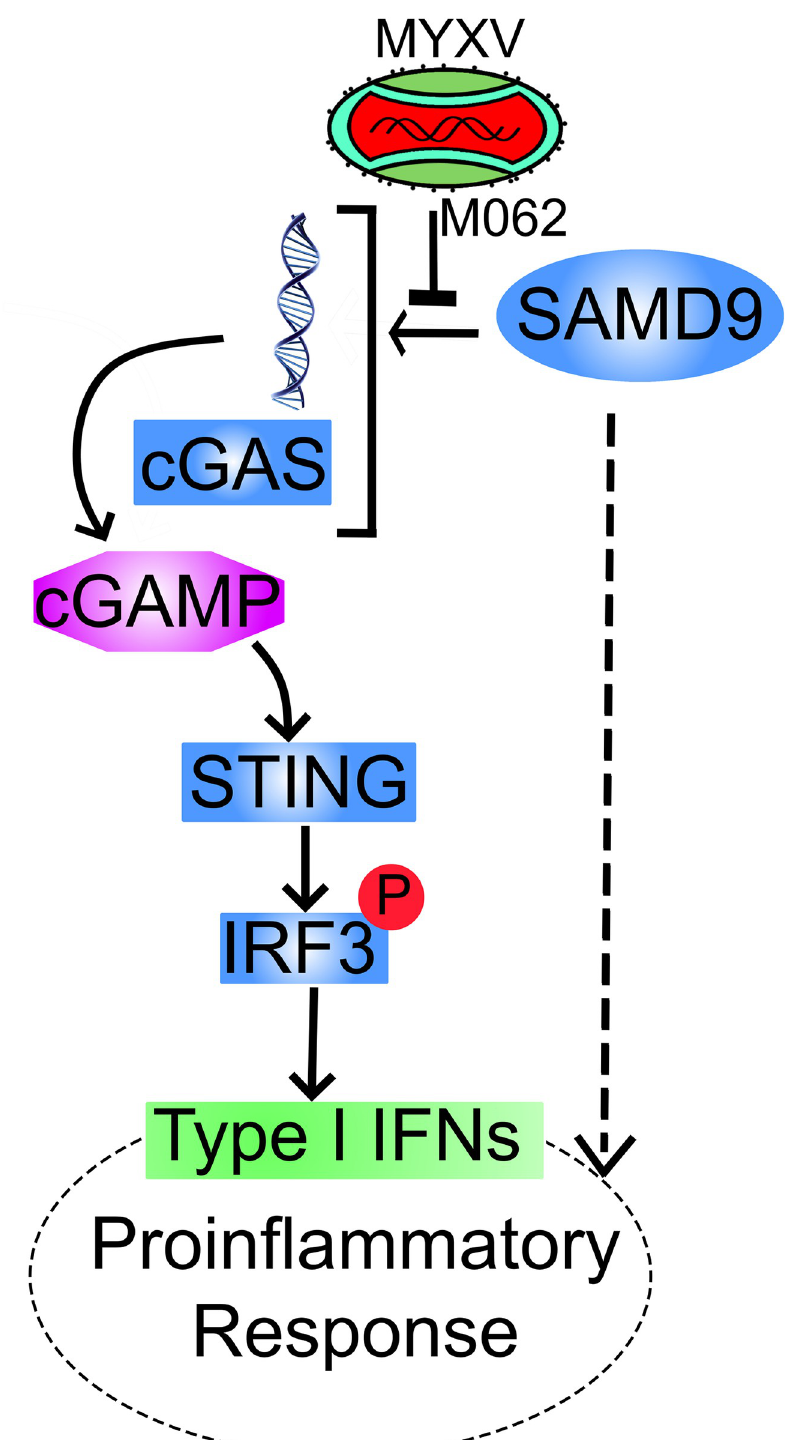
Fig 7. Summary of SAMD9 effect to DNA sensing pathway and proinflammatory responses. Based on our finding, the lack of M062R during MYXV infection induces cGAS-dependent IFN-I production that is also regulated by SAMD9. The SAMD9 effect is at the upstream of the 2’3’-cGAMP production but does not significantly affect cGAS protein synthesis. Overall, SAMD9 plays a positive role in enhancing cGAS-dependent IFN-I induction and regulating the proinflammtory responses in our model system (the dotted